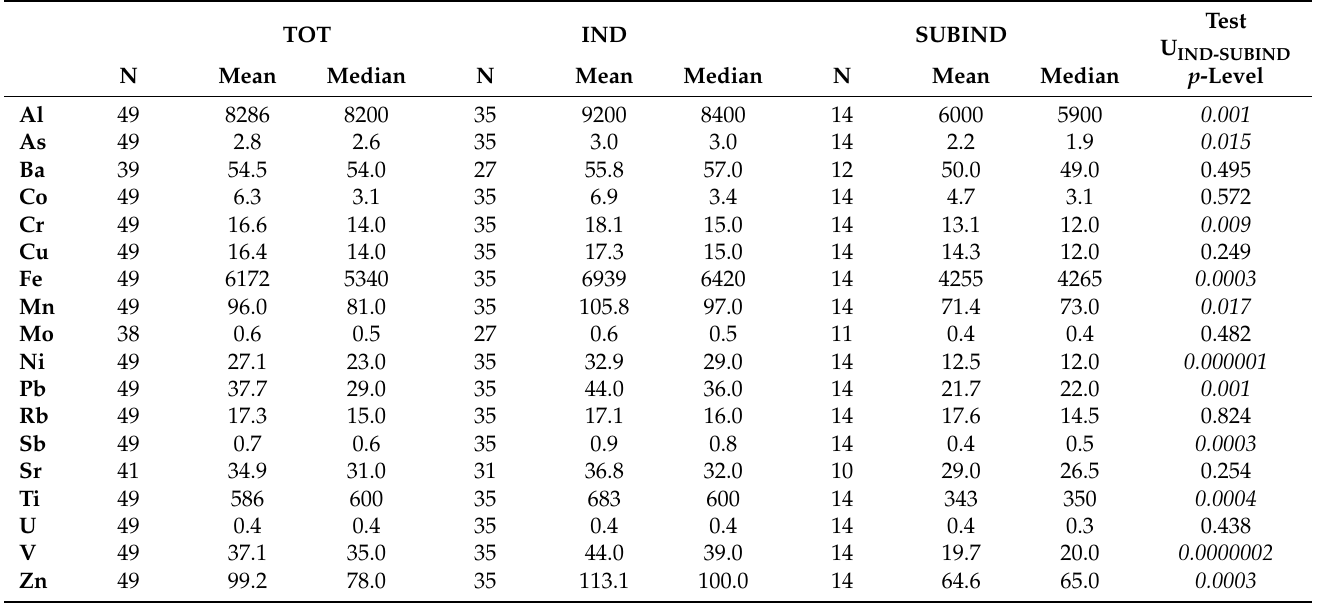
Table 1. Mean and median concentrations for 18 trace elements analyzed in lichen samples. TOT: total database; IND: samples near the industrial plant; SUBIND: control samples. Test U: Mann-Whitney test ( p < 0.05). The level with statistical significance is indicated in italics.